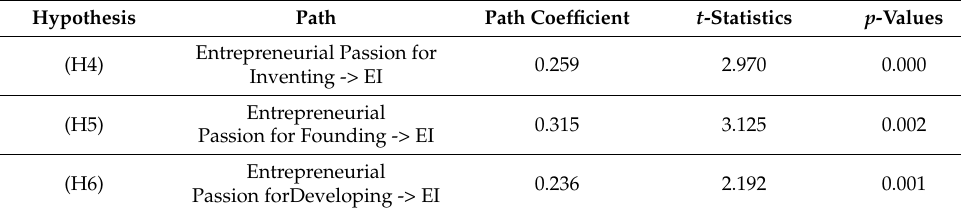
Table 5. Moderation